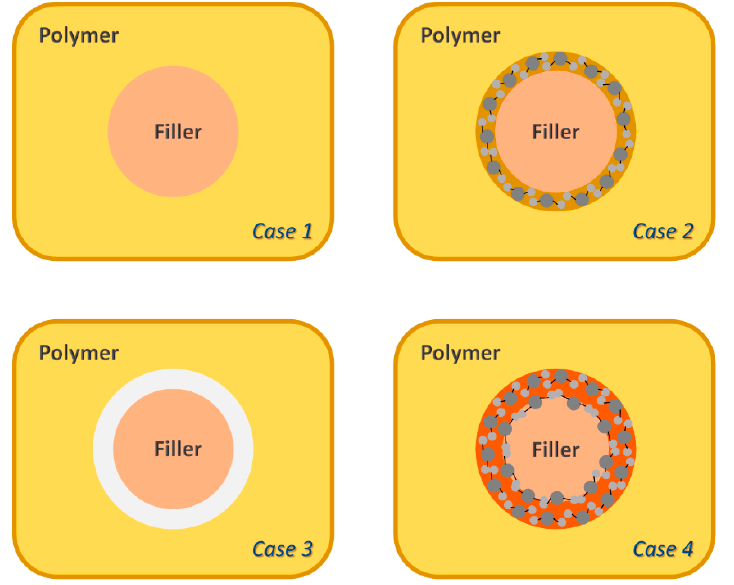
Figure 9. Schematic diagram on the types of cases for the polymer-filler interactions HFMMMs [105].